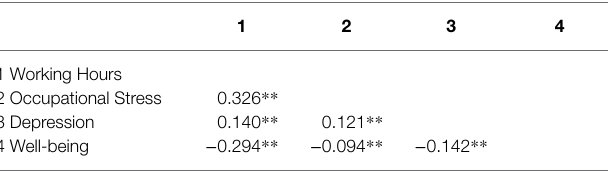
TABLE 2 | Pearson’s correlation coefficients between working hours, depression, occupational stress, and